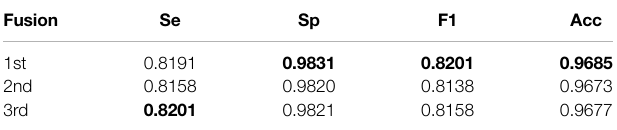
TABLE 2 | Performance on the three fusion mechanisms. Fusion